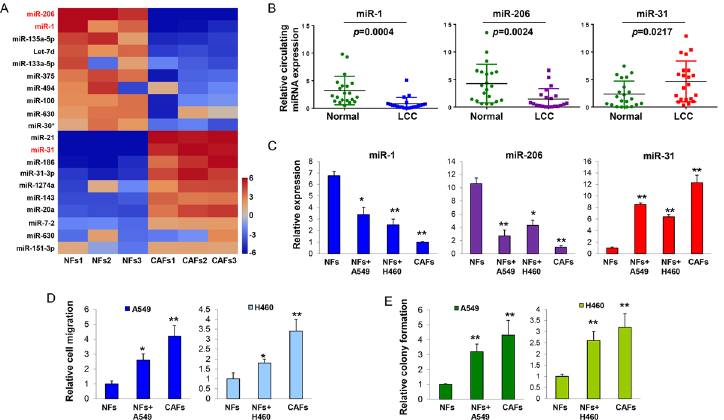
Fig 1. Identification of deregulated miRNAs in CAFs compared with NFs. (A) Heat map showing levels of top 20 significantly deregulated miRNAs in three pairs of CAFs and matched healthy NFs. Red, up-regulated; blue, down-regulated. The two most down-regulated miRNAs and one most up-regulated miRNA are highlighted. (B) Plasma levels of miR-1, miR-206 and miR-31 in 21 lung cancer patients and 21 healthy subjects were determined by Taqman qRT-PCR assay. Experiments were performed in triplicate and each repeated three times. (C) RFP-expressing LCCs were co-cultured with NFs for 10 days. Co-cultured NFs were flow-sorted. Levels of miR-1, miR-206 and miR-31 in NFs, co-cultured NFs (with A549 or H460), and CAFs cells were determined by Taqman qRT-PCR assay, and normalized to the U6 levels. (D) LCCs were seeded on the top of a Boyden chamber. The numbers of cells that migrated through the uncoated filter in response to conditional medium (CM) from co-cultured cells (A549/H460+NFs, A549/H460+co-cultured NFs, or A549/H460+CAFs) in the interior sides of the chamber were counted and normalized to LCCs alone. The mean number of cells per field was determined from three fields in three replicated wells. * p < 0.05, ** p < 0.001 vs NFs+LCCs coculture. (E) LCCs were mixed with agarose and seeded into 6-well plates. The CM mediums were added to the wells and be replaced by every two days. After 12 days of culture, colonies were fixed with 100% methanol for 15 min and stained with 0.1% crystal violet. Colonies with diameter more than 1.5 mm were counted. The experiments were performed with three replicates, and repeated for 3 times. ** p < 0.001 vs NFs+LCCs